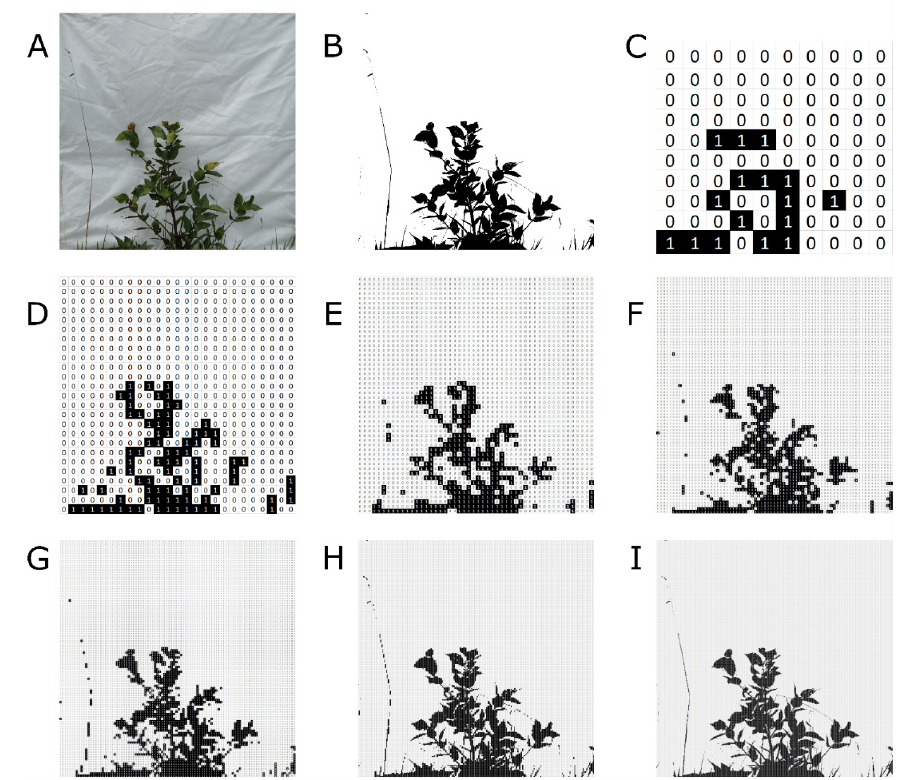
Figure 2. Comparison of different resamplings from a figure of 2500x2500 pixels. A ) Original image. B ) Black and white conversion of the original image by GIMP software, i.e. all pixels converted to either black or white in image. C – I ) conversion of the original image to binary matrices of 10×10, 50×50, 75×75, 100×100, 250×250, and 500×500,